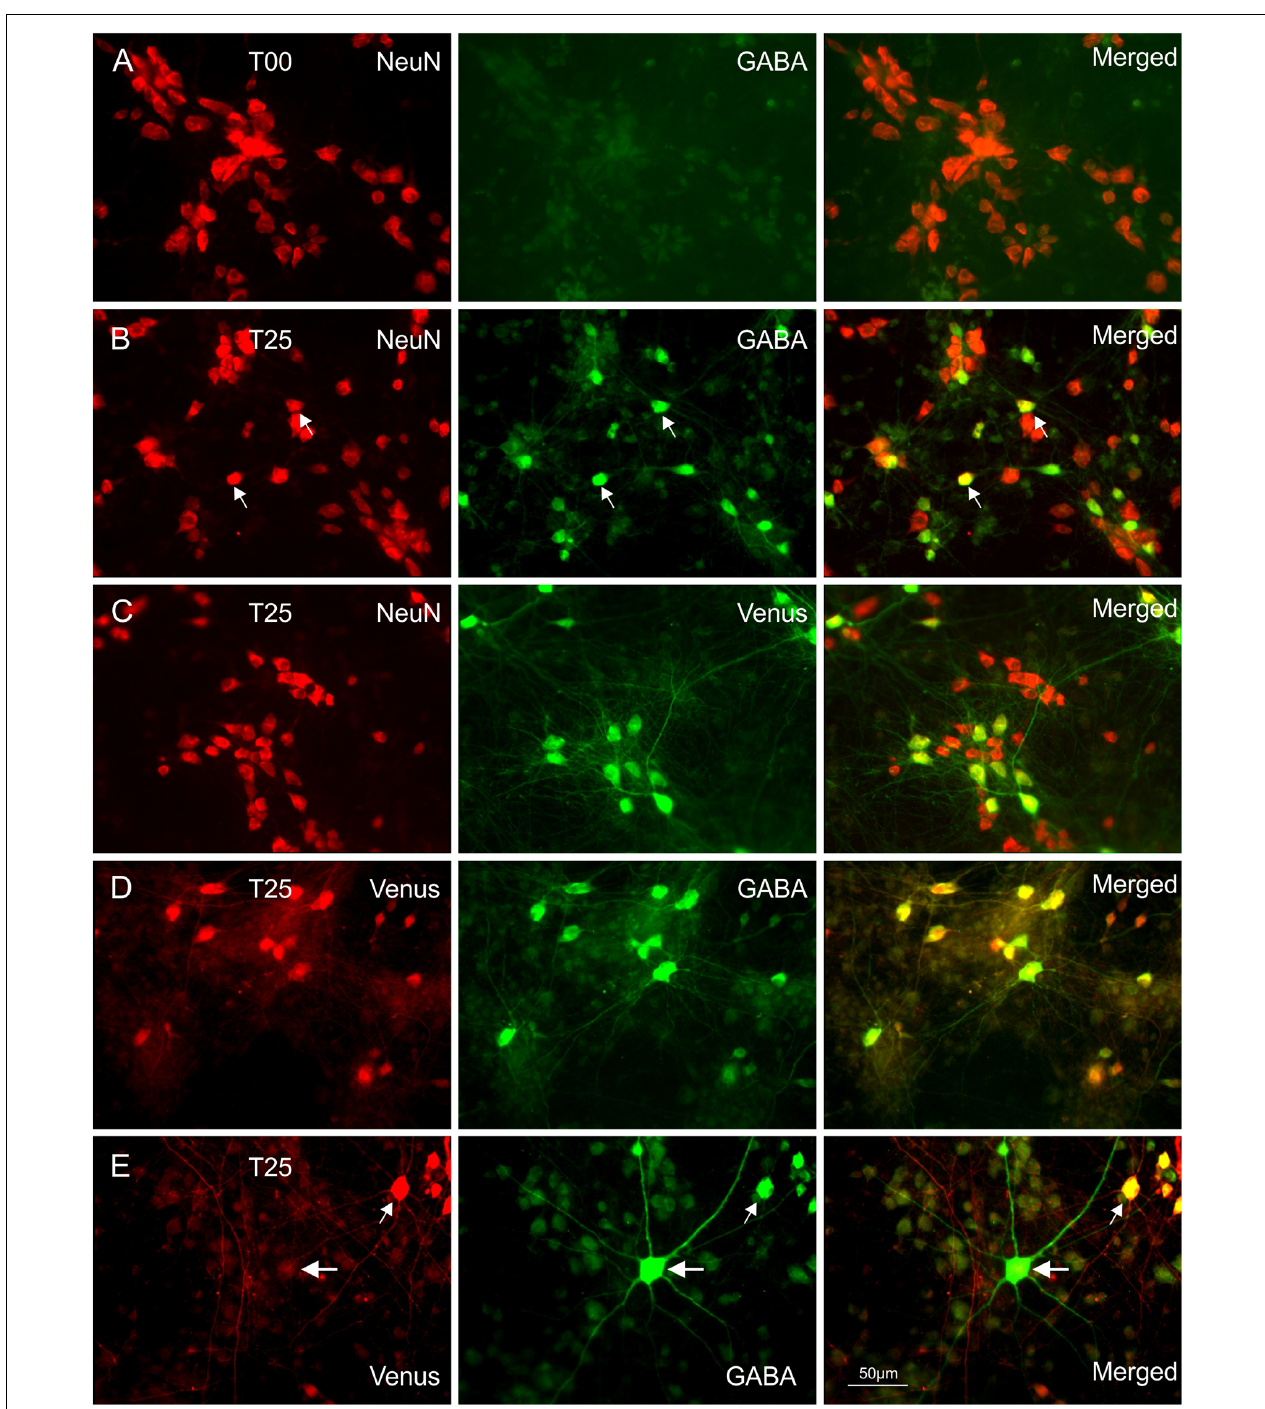
FIGURE 1 | Immunocytochemical double staining for co-localization of NeuN with GABA or Venus. Images in (A) show a NeuN/GABA double-stained culture obtained from dissociated embryonic rat wild-type dorsal cortices (dCtx) at E16 (T00 network). In this network type, the vast majority of neurons were pyramidal neurons (PNs). Images in (B) show a NeuN/GABA double-stained wild-type dCtx with 25% Venus MGE-INs (T25: MGE-INs from transgenic vGAT Venus rats). Arrows point to two strongly positive NeuN/GABA neurons. (C) Images of a NeuN/Venus double-stained T25 culture show the vGAT-Venus expressing MGE-INs. (D) Images of a double-stained T25 culture show the GABA co-localization in Venus expressing neurons. (E) Images of a Venus/GABA double-stained T25 culture show one example of the rare Venus negative INs found in very low density in dCtx cultures (large arrows). The double-labeled Venus/GABA expressing neurons (small arrows) were of MGE origin (MGE-INs) from E14 transgenic animals. All images in (A–E) show 14-day-old cultures.